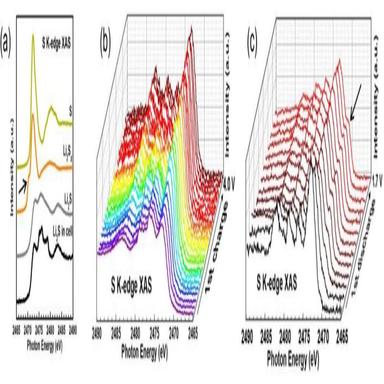
(a) Reference XAS spectra of sulfur, LiPSs, and Li2S, as well as that of the Li2S electrode in cell. (b) S K-edge XAS spectra collected simultaneously with electrochemical cycling at a C/15 rate during the first charge process. (c) S K-edge XAS spectra collected simultaneously with electrochemical cycling at a C/10 rate during the first discharge process. Reproduced from Ref. with permission from the American Chemical Society.